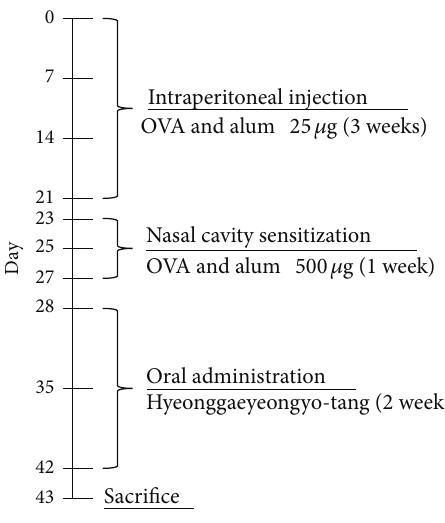
Figure 1: Allergic rhinitis